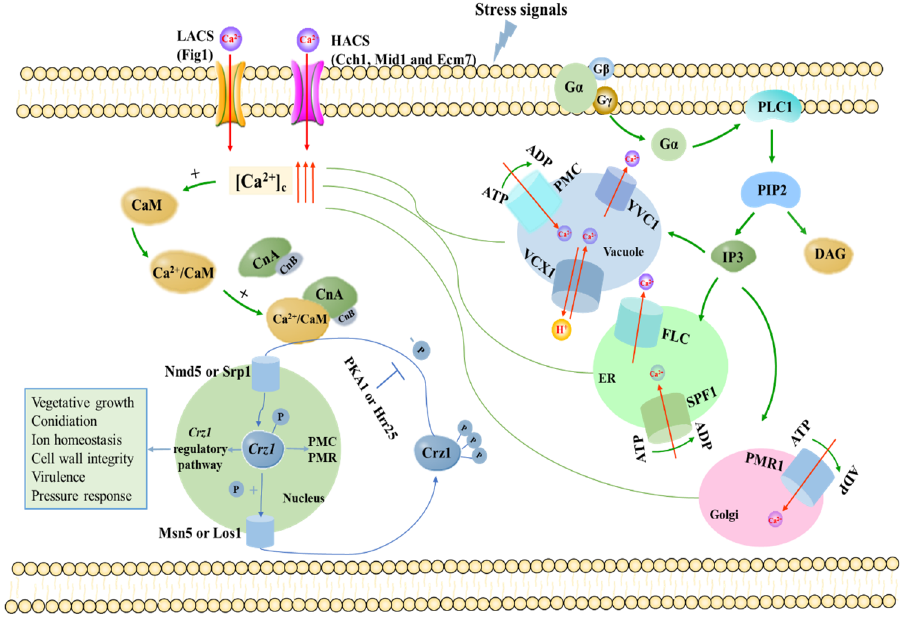
Figure 1. Pattern of calcium homeostasis system in fungi. When the cytosolic Ca 2+ concentration increases, calmodulin activates calcineurin, which in turn dephosphorylates Crz1. Crz1 is then imported into the nucleus and induces or represses expression of its target genes. HACS: high- affinity calcium system; LACS: low-affinity calcium system; [Ca 2+ ] c : cytosolic calcium concentration; CaM: calmodulin; CnA: calcineurin catalytic subunit; CnB: calcineurin regulatory subunit; Crz1: calcineurin responsive transcription; PMC: plasma membrane Ca 2+ -ATPase; PMR: plasma membrane ATPase-related pump; ER: endoplasmic reticulum; FLC: flavin carriers; PLC1: phospholipase C; PIP2: inositol-4,5-diphosphate; IP3: inositol triphosphate; DAG: diacylglycerol. There are many kinds of calcium pools in fungal cells, such as endoplasmic reticu- lum, Golgi apparatus and vacuoles. Different calcium pumps are distributed in these cal- cium pools, and are responsible for transporting Ca 2+ from the cytoplasm to various orga- nelles against the concentration gradient. For fungal cells, vacuoles rather than endoplas- mic reticulum are the most important calcium pools, where the concentration of Ca 2+ is about 10 4 times that of cytoplasmic [54,55]. This large amount of Ca 2+ storage is maintained by the action of two transporter proteins, Ca 2+ -ATPase Pmc1 and Ca 2+ /H + exchanger Vcx1 [10,26,56–60]. Vcx1 belongs to the CAX superfamily of calcium-permeable ion exchangers [61–63]. When there is a burst in the cytoplasmic content of calcium, the Vcx1 transporter sequesters the calcium into the vacuoles. In addition to calcium, the Vcx1 protein trans- ports Mn 2+ ions, thus allowing S. cerevisiae to grow in high concentrations of either calcium or manganese ions [64]. Pmr1 (Plasma membrane ATPase related) is the first member of the secretory pathway Ca 2+ -ATPase (SPCA) family, which mediates the transport of Ca 2+ and Mn 2+ in Golgi under normal physiological conditions [56,65–69]. In order to precisely regulate intracellular calcium signals, organisms have also evolved several calcium-sensing proteins to respond to different ranges of Ca 2+ concentra- tion levels [70]. CaM, located downstream of phospholipase C [71] in the calcium signal- ing pathway, is a very important Ca 2+ sensor that can sense the change of intracellular Ca 2+ concentration and regulate a series of downstream target proteins by binding with Ca 2+ [72–74]. CaN, as a Ca 2+ and CaM dependent serine/threonine protein phosphatase, is com- posed of the catalytic subunit CNA and the regulatory subunit CNB [75–79], and is the central mediator of the Ca 2+ /calmodulin/calcineurin/Crz1 signaling pathway. In fact, cal- cineurin regulates the activity of diverse calcium transporters on the plasma membrane and is mainly responsible for calcium homeostasis [80]. Upon Ca 2+ presence, the activated CaM binds to the CNA and CNB complexes to form a fully activated trimer [81], and then activated CaN dephosphorylates Crz1 and transfers it to the nucleus to regulate the